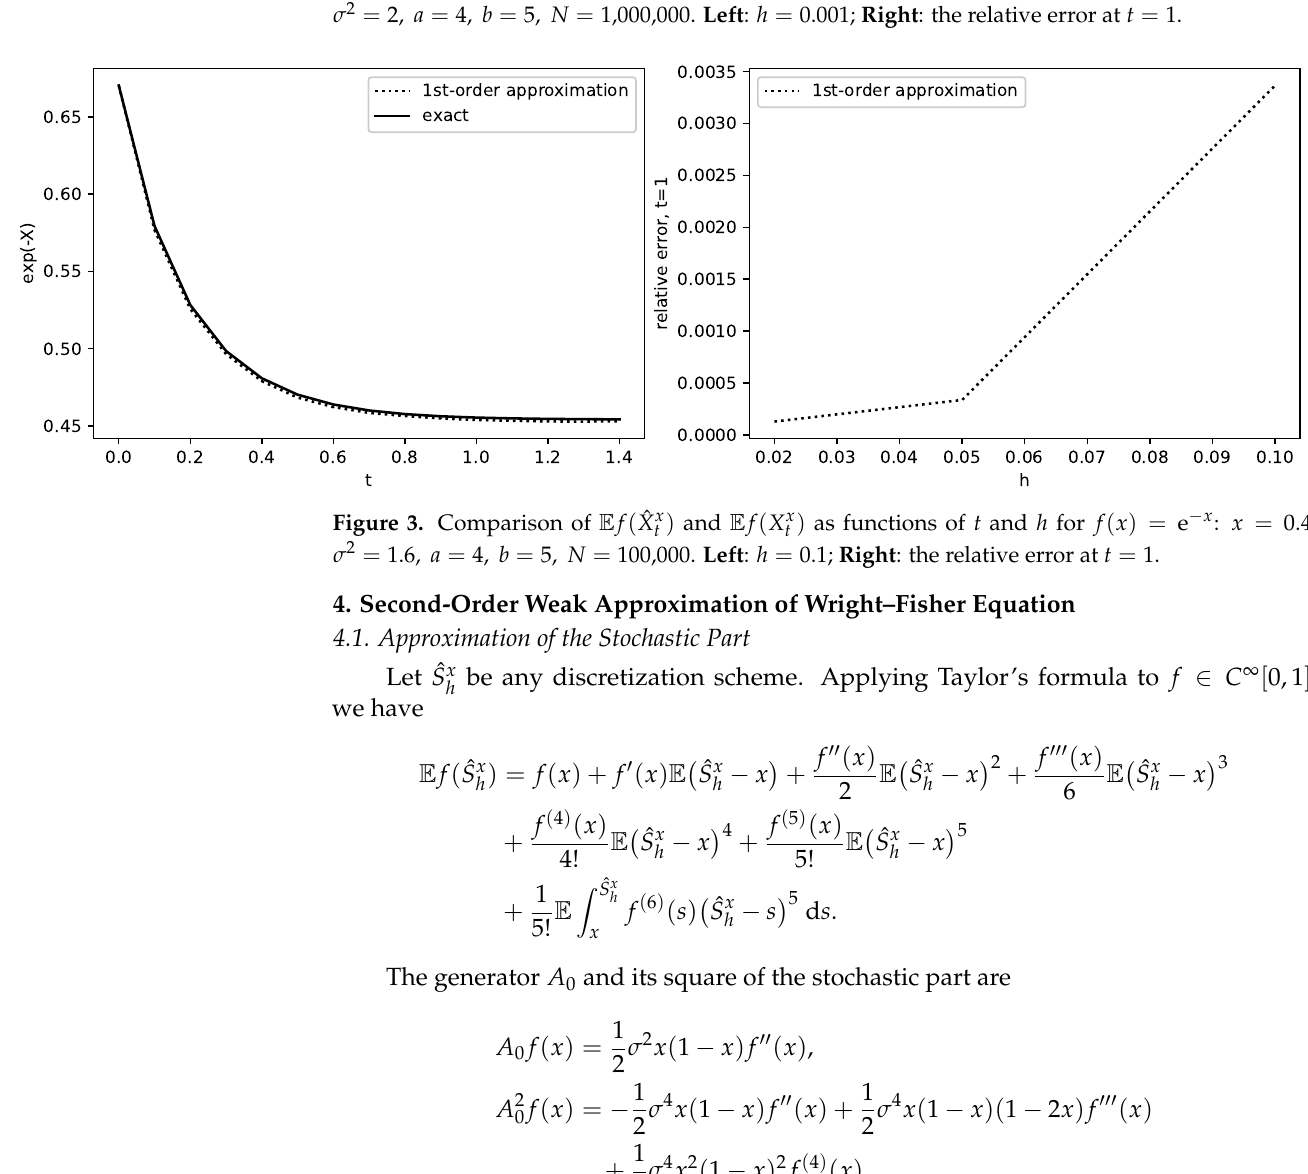
) and E f ( X x ) as functions of t and h for f ( x ) = x 5 : x = 0.83, t t